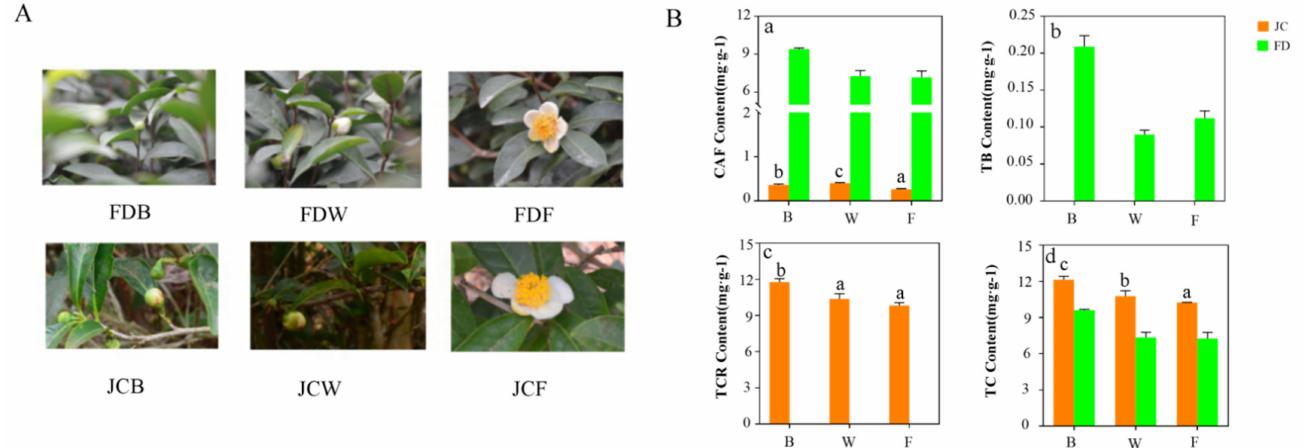
Figure 1. Morphological characteristics of tea blossom ( A ). JCB, FDB is the flower bud stage. JCW, FDW is the whitening stage; JCF, FDF is the full opening stage. Purine alkaloids content in Kucha (JC) and conventional varieties (FD); ( B ). a.